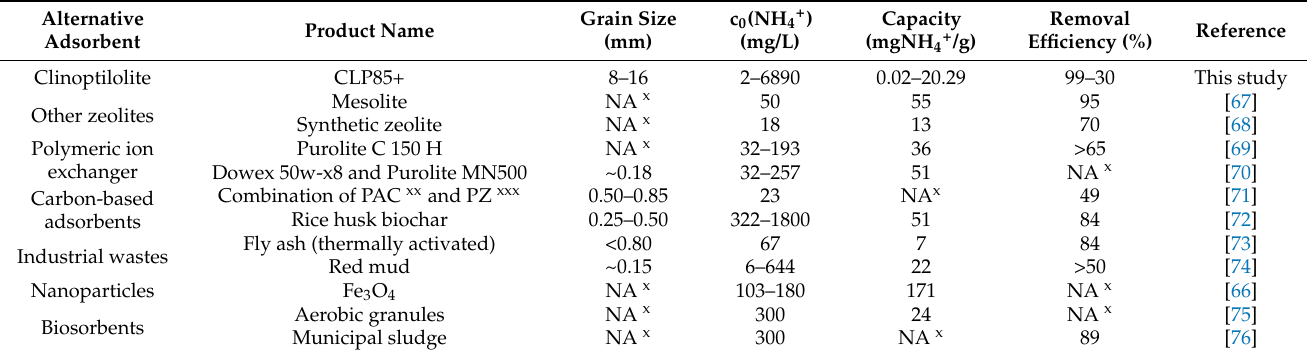
Table 4. Alternative adsorbents used for NH 4+ removal, summarized from Huang et al. [34] and Gupta et al.